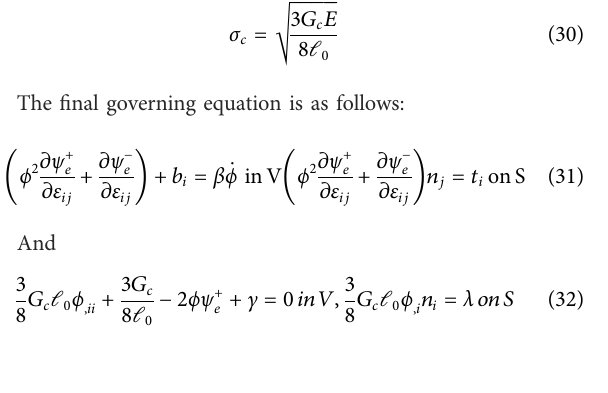
As shown in Figure 2, the function curve under different s values. The characteristic of this degradation function is that a parameter s is introduced to control the speci fi c peak stress through different values of s. We can easily calculate the peak stress of different s values by the following